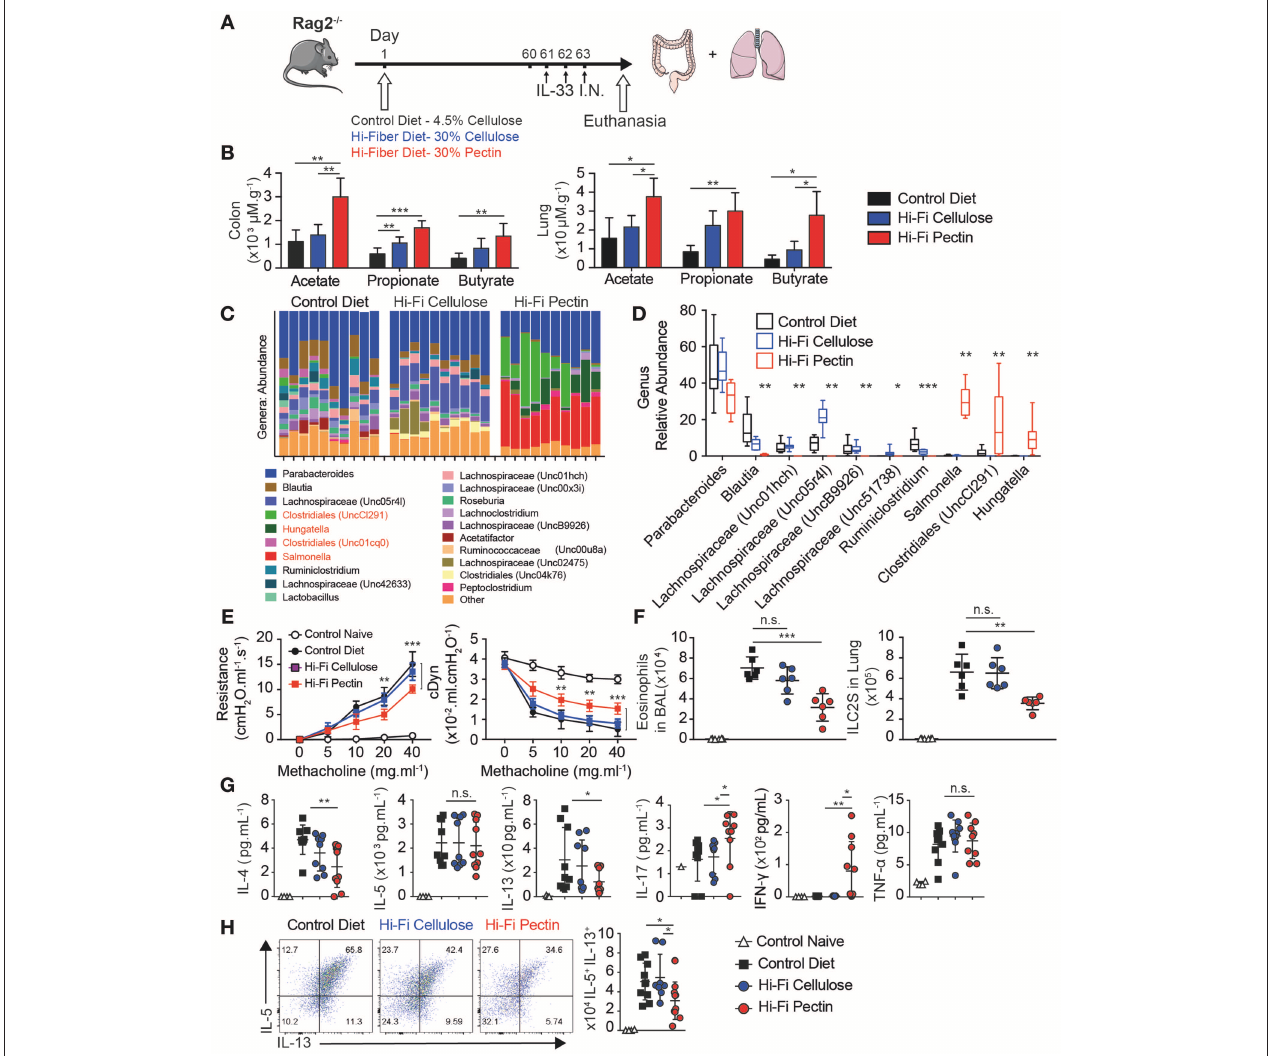
FIGURE 1 | High-fiber diets dampens allergic asthma. Five week-old RAG − / − were provided normal chow with 4.5% cellulose (Control Diet) or enriched with 30% cellulose (Hi-C) or 30% Pectin (Hi-P) as fiber source. After 2 months mice were treated with IL-33 intranasally ( i.n. ) for 3 consecutive days, followed by analysis of lung inflammation by flow cytometry. (A) Schematic. (B) Amounts of acetate, propionate, and butyrate in colon and lung tissue by LCMS. (C) Genus abundance by OTU count in fecal pellet by 16S V4 profiling in individual mice as columns. (D) Average proportions of most abundant bacterial genera. (E) Resistance (cmH 2 0/mL/S) and Dynamic compliance (mL/cmH 2 0) in anesthetized tracheotomized mice challenged with increasing dose methacholine. (F) Number of Eosinophils and ILC2 infiltrating BAL fluid. (G) BAL cytokine production by Luminex. (H) Intracellular cytokine production by Lung ILC2 after 12h of IL-33 followed by Brefeldin A (BFA) of total lung cells, gated as Live CD45 + Lineage − CD90.2 + CD127 + ST2 + . Shown are representative plots and total number of IL-5 vs. IL-13 producing cells in lung. Data representative of two of four independent experiment, n = 4–5 mice/group + -SD. * p < 0.05, ** p < 0.01, and *** p <